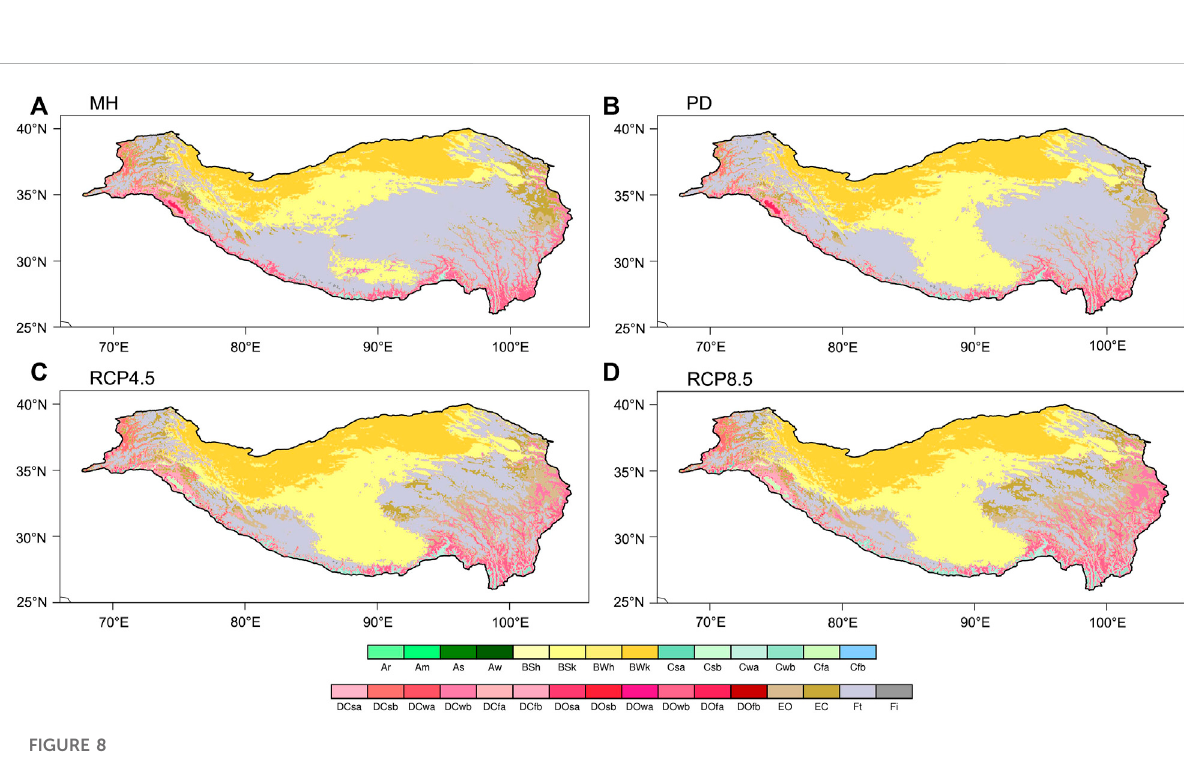
Frontiers in Earth